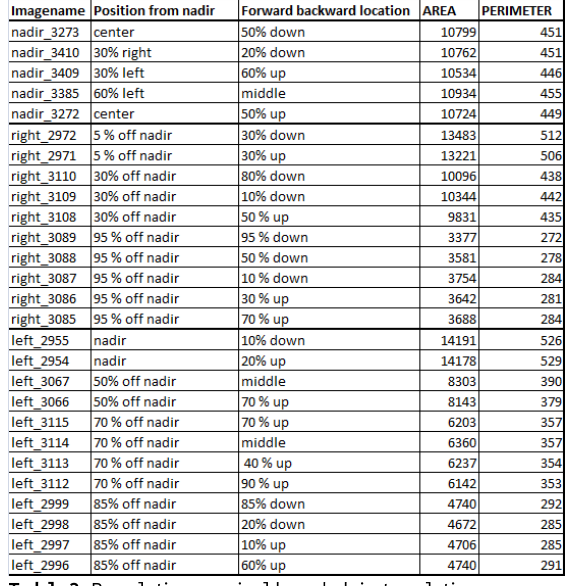
Table 3 . Resolution on pixel-based object